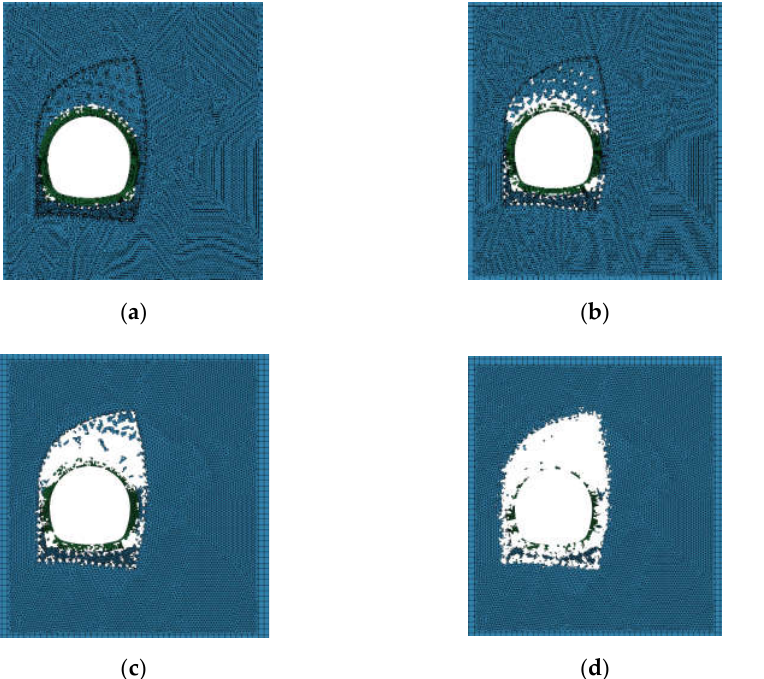
Figure 5. Sate of tunnel lining and rock in blasting process: ( a ) T = 0.4 × 10 −4 s; ( b ) T = 0.16 × 10 −3 s; ( c ) T = 0.4 × 10 −3 s; ( d ) T = 0.8 × 10 −3 s.